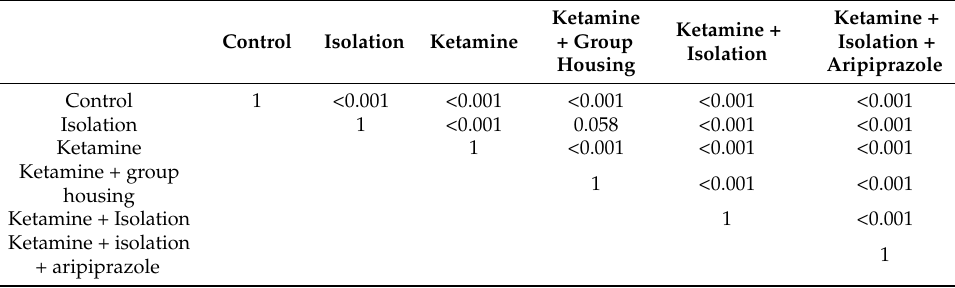
Table 7. All p -values for the level of MDA in the